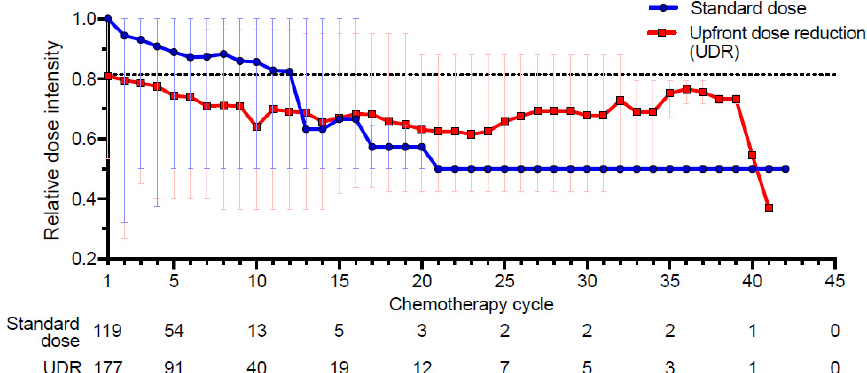
Figure 2. Changes in relative dose intensity (RDI) of the standard dose and UDR groups. The dotted line demonstrates each mean RDI chemotherapy cycle, and the error bar demonstrates RDI ranges.